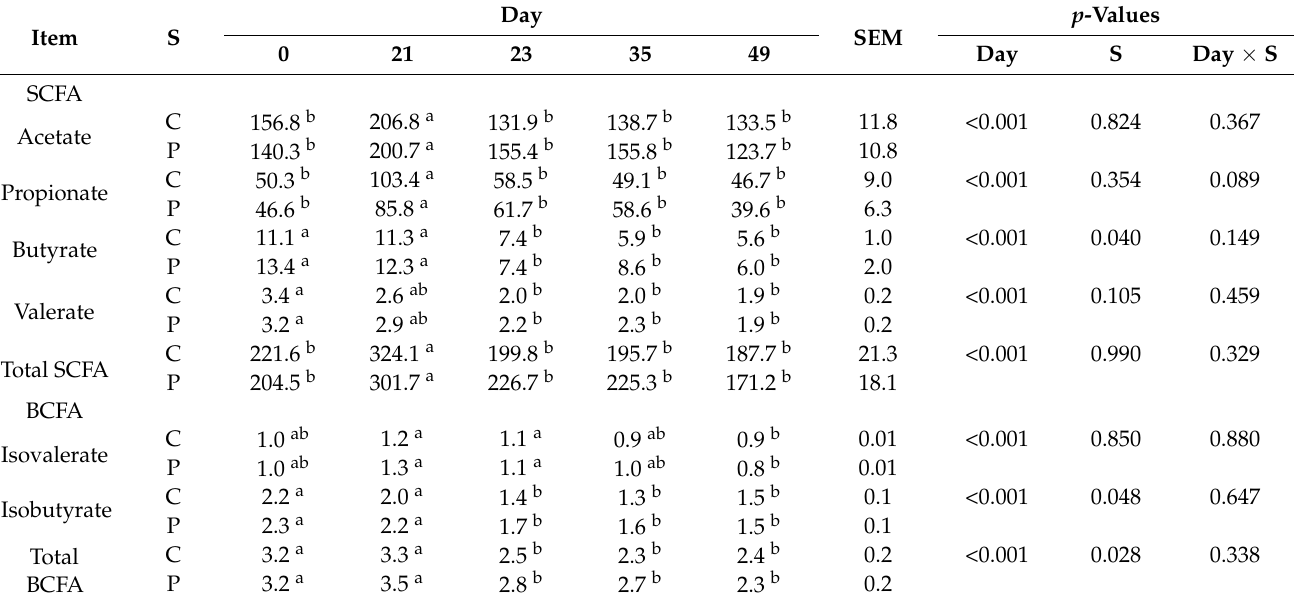
Table 4. Means of fecal concentration ( µ mol/g dry matter) of short-chain fatty acids (SCFA) and